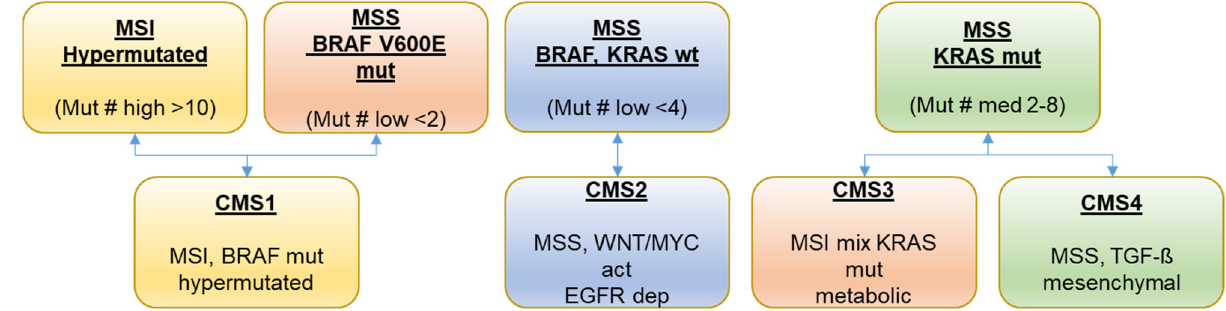
Figure 3. Genomic classification of colon cancer subgroups.